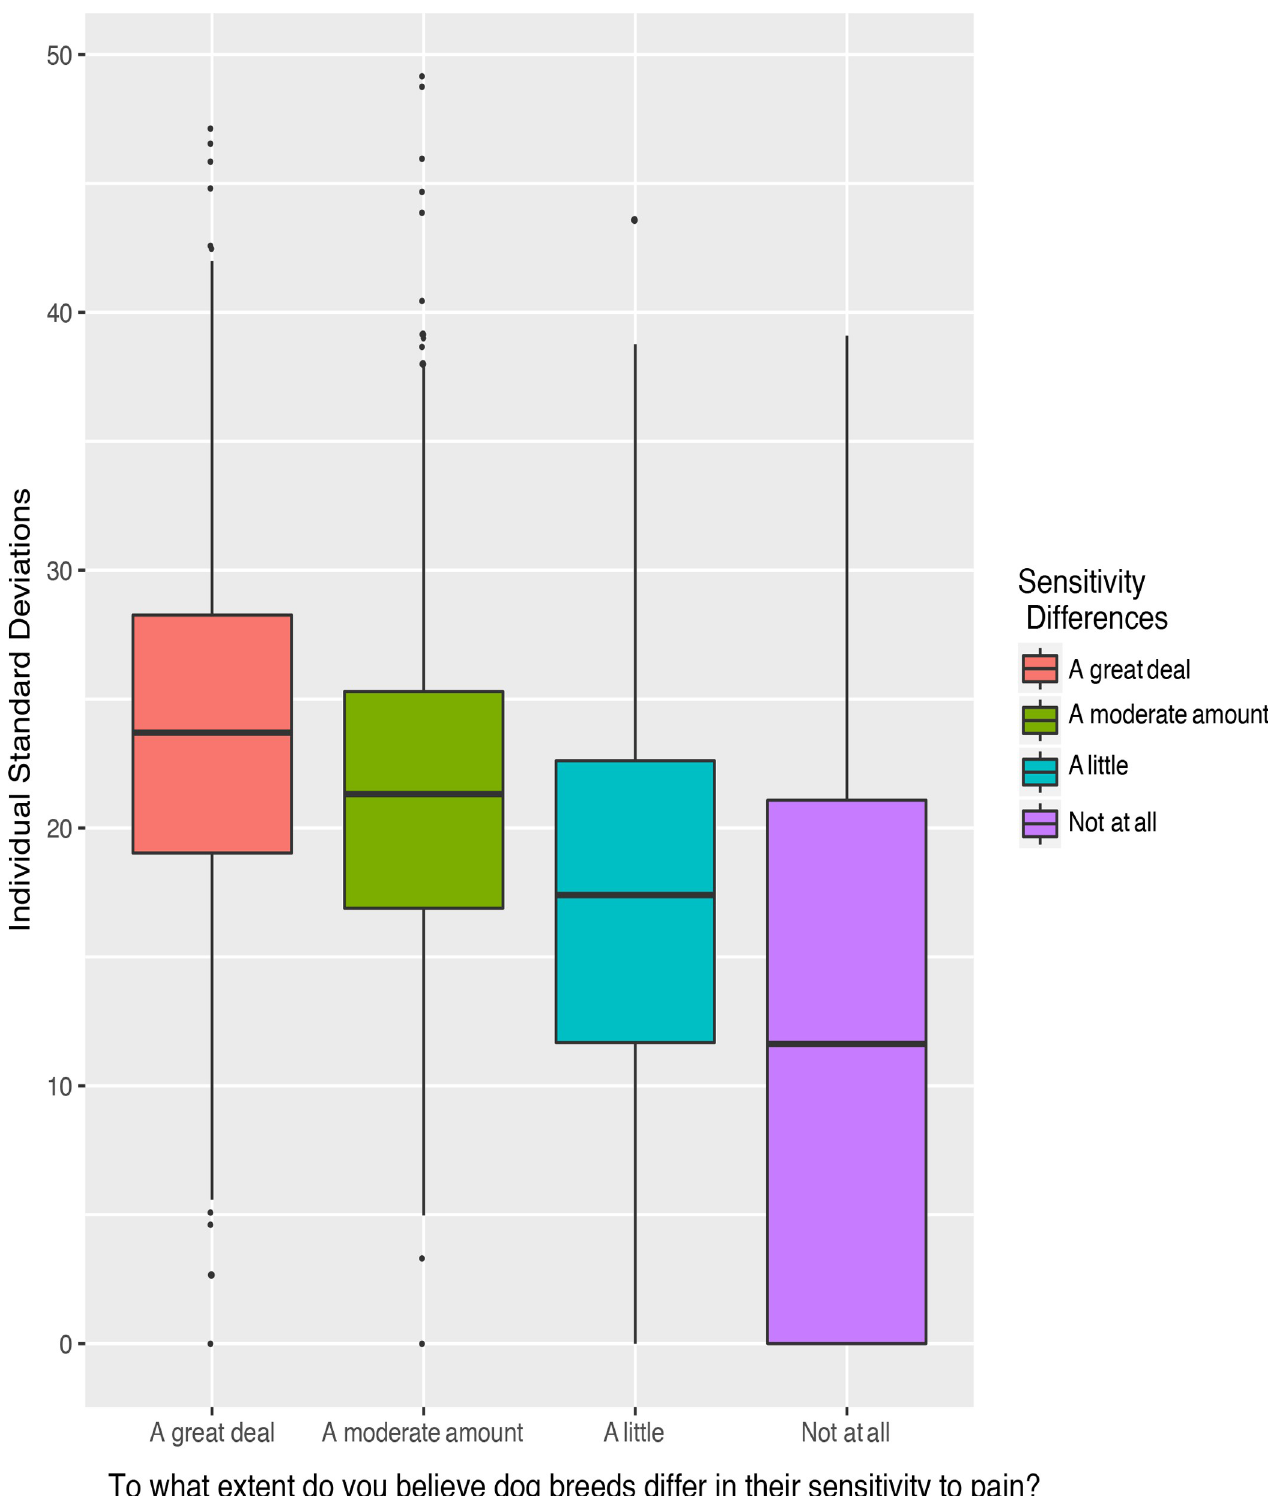
Fig 2. Box-and-whisker plot (median, interquartile range, and 1.5 interquartile range) of individual standard deviations across ratings of dog breeds for each level of response to the question regarding extent of belief in a difference in sensitivity for dog breeds. Standard deviations were significantly different for each group (corrected p < 0.05 for each comparison). This figure shows aggregate responses across the two groups; number of individuals in each group were: A great deal (n = 708), A moderate amount (n = 1007), A little (n = 335), and Not at all (n = 81). https://doi.org/10.1371/journal.pone.0230315.g002 PLOS ONE | https://doi.org/10.1371/journal.pone.0230315 March 17,